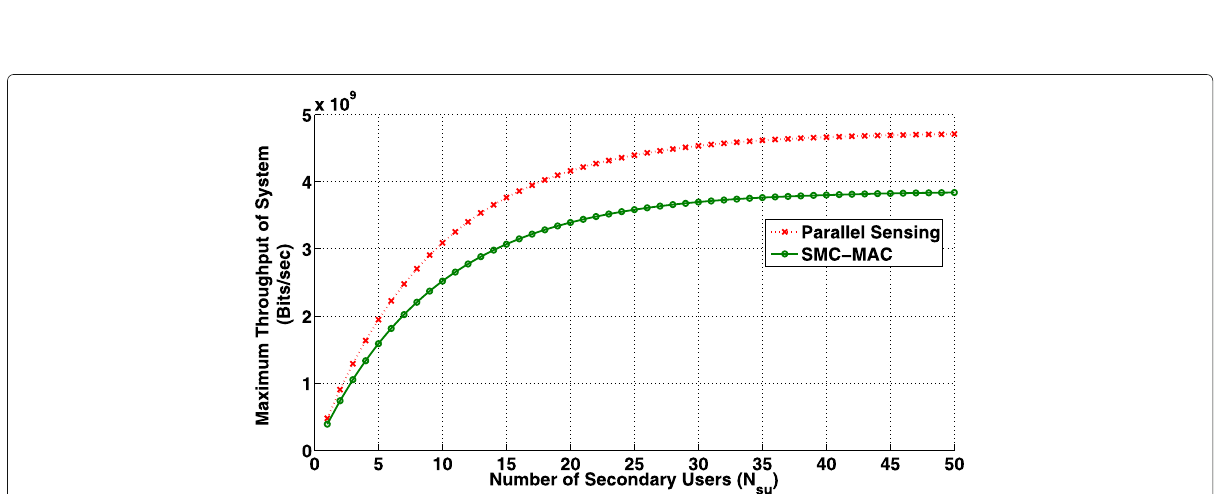
Fig. 15 Comparison of the maximum throughput of the system between parallel sensing scheme and SMC-MAC [27], with parameters N g = 10, ch max = 10, γ = 10, and N ch =